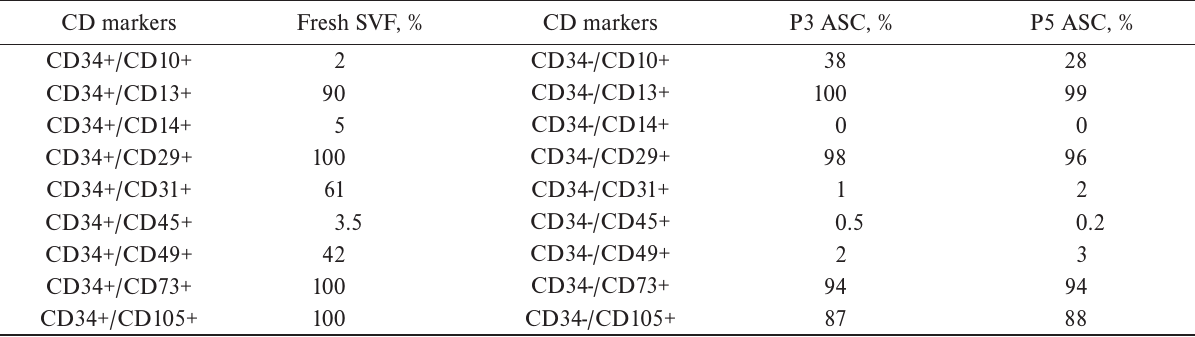
Table 1. Characterization of cell population of freshly obtained SVF and cultured ASC at passages 3 (P3) and 5 (P5) using a flow cytometric technique 8